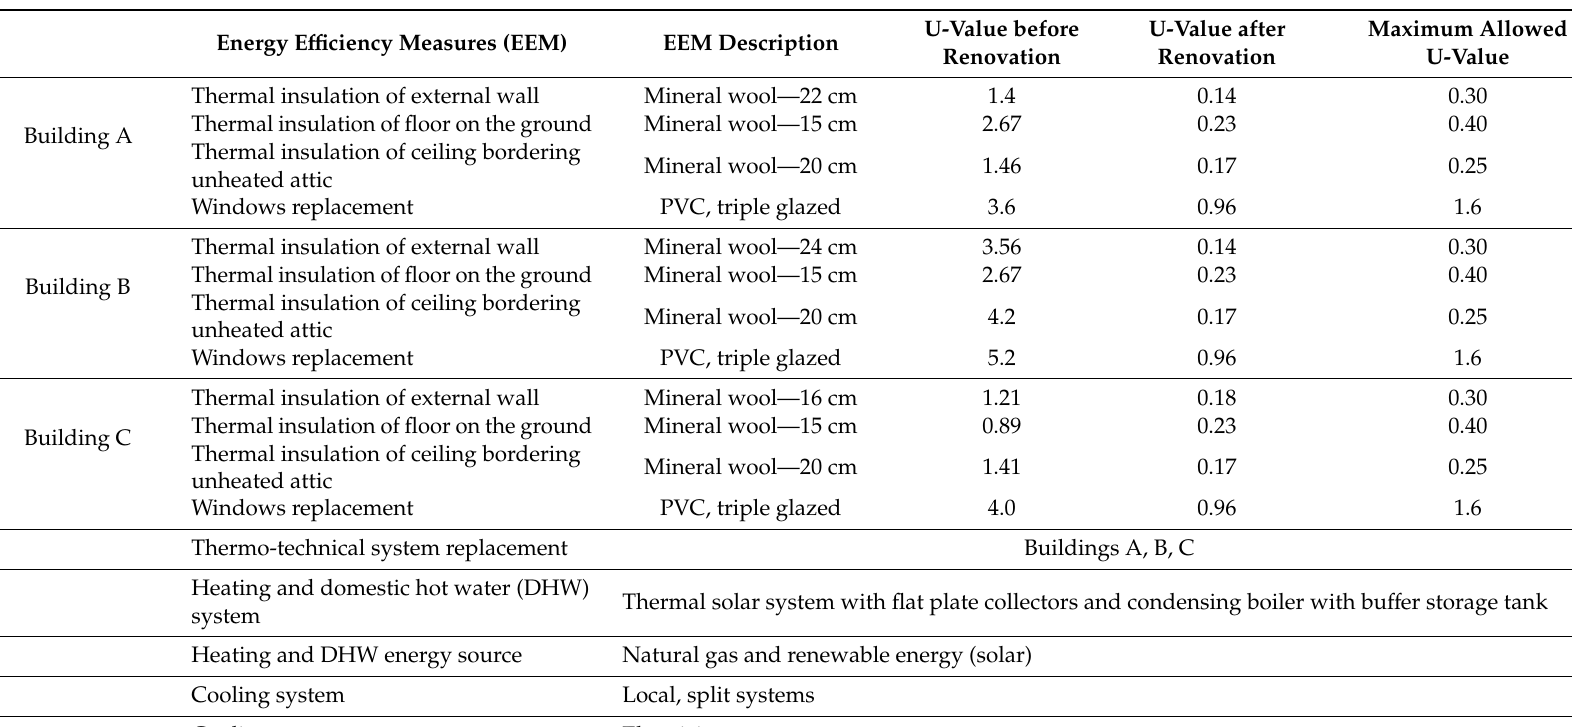
Table 3. Proposed energy e ffi ciency measures of the analysed case study